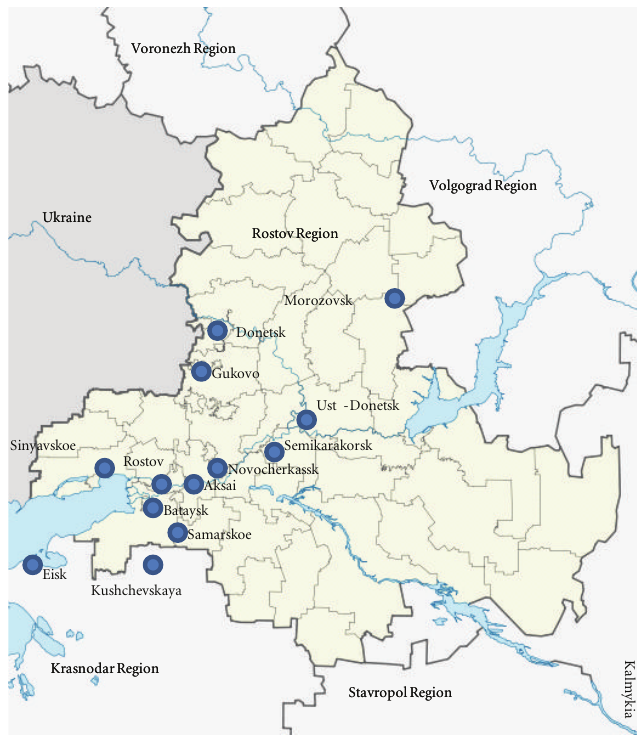
Figure 3: Rostov Region map. It is indicated the living places of the human healthy blood donors that have antibodies to Dirofilaria spp. somatic